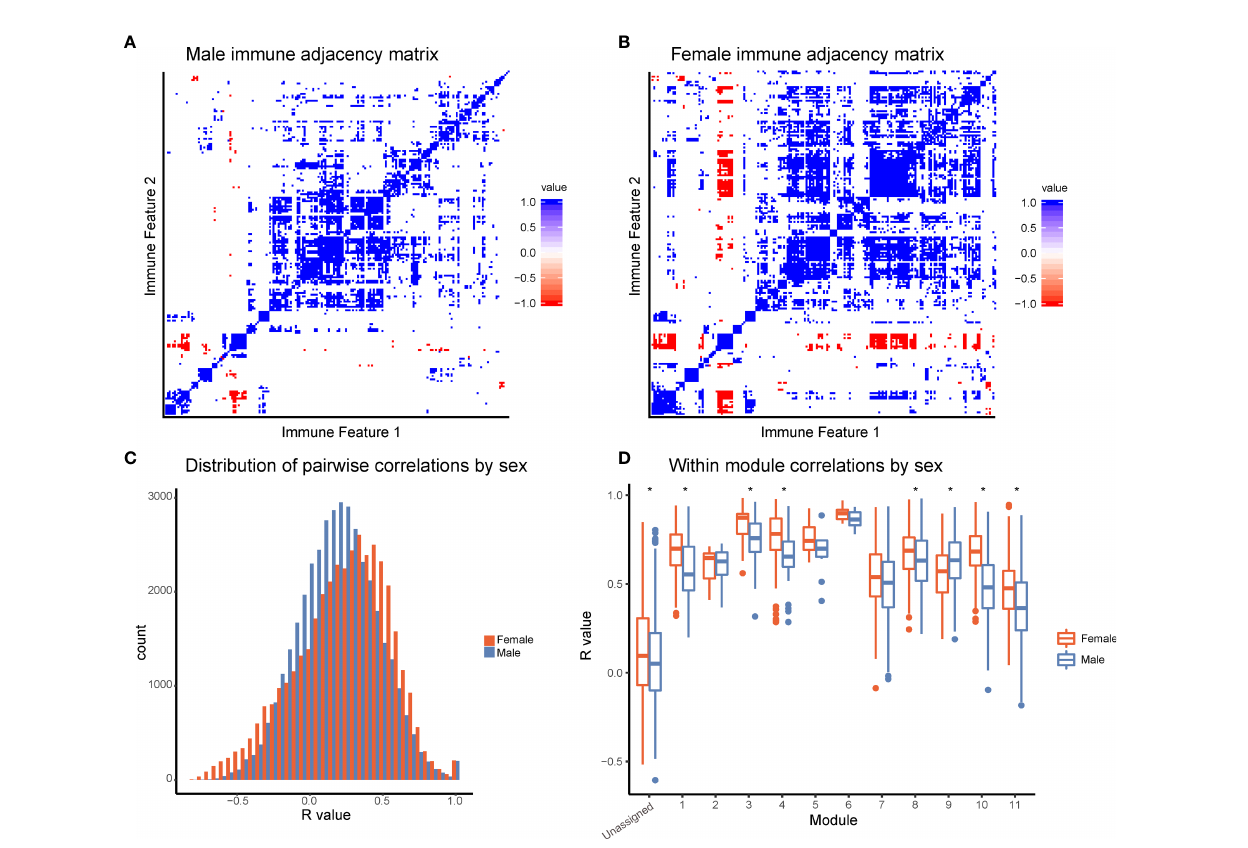
FIGURE 4 | Females have increased coordination of immune cell signaling capacity. (A) Adjacency matrices of 199 immune features across male donors. R-values were binned; R-values from -1 to -0.5 are red, from -0.5 to 0.5 are white, and from 0.5 to 1 are blue. Feature order was set by the clustering order on the full dataset. (B) Adjacency matrices of 199 immune features across female donors. R-values were binned; R-values from -1 to -0.5 are red, from -0.5 to 0.5 are white, and from 0.5 to 1 are blue. Feature order was set by the clustering order on the full dataset. (C) Distribution of correlation coef fi cients (R-values) of each pairwise feature in male donors (turquoise) compared to female donors (pink). Distributions were signi fi cantly different (p-value = 2.2x10-16, Wilcoxon sum-rank test). (D) Box- plots of correlation coef fi cients (R-values) within modules grouped by sex. Modules are numbered as in Figure 2C . Females (pink) had higher levels of correlation in modules 1, 3, 4, 8, 10, 11, and unassigned (Wilcoxon sum-rank test, adjusted p-value <.05). Males (turquoise) had higher levels of correlation in module 9. (* indicates Wilcoxon sum-rank test adjusted p-value